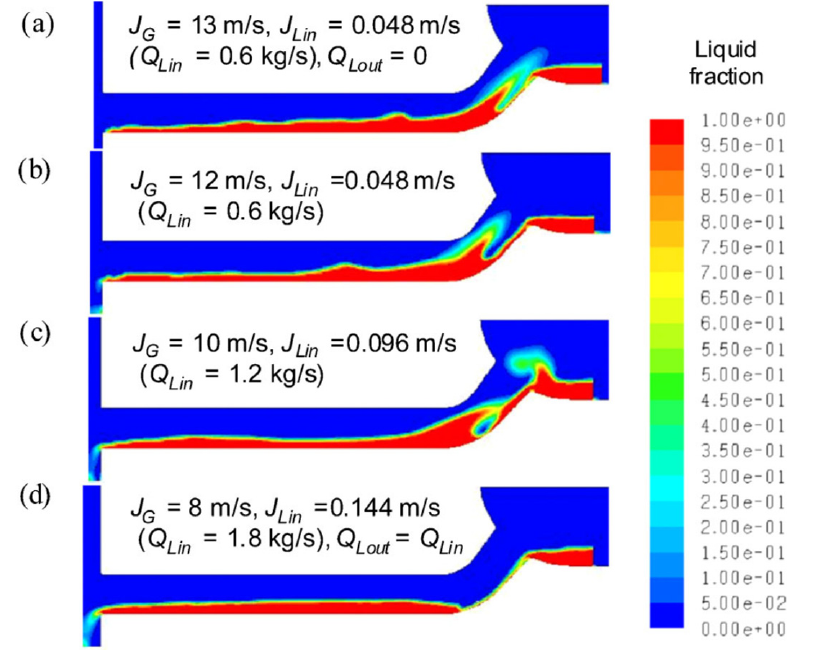
Figure 17. Flow patterns predicted by the two-fluid model (0.15 MPa); ( a – d ) flow patterns for different simulation cases (Kinoshita et al. [101]).